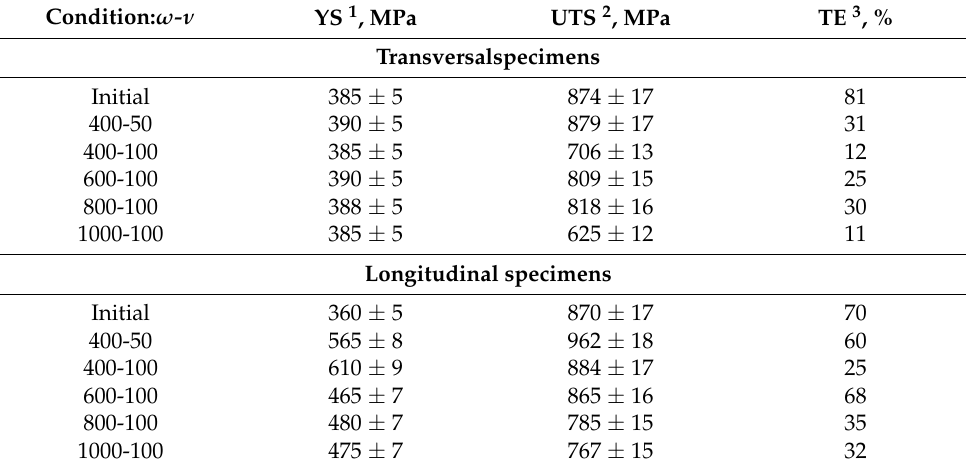
Table 3. Mechanical properties of FSW welds in the Fe 49 Mn 30 Co 10 Cr 10 C 1 alloy obtained using transversal or longitudinal